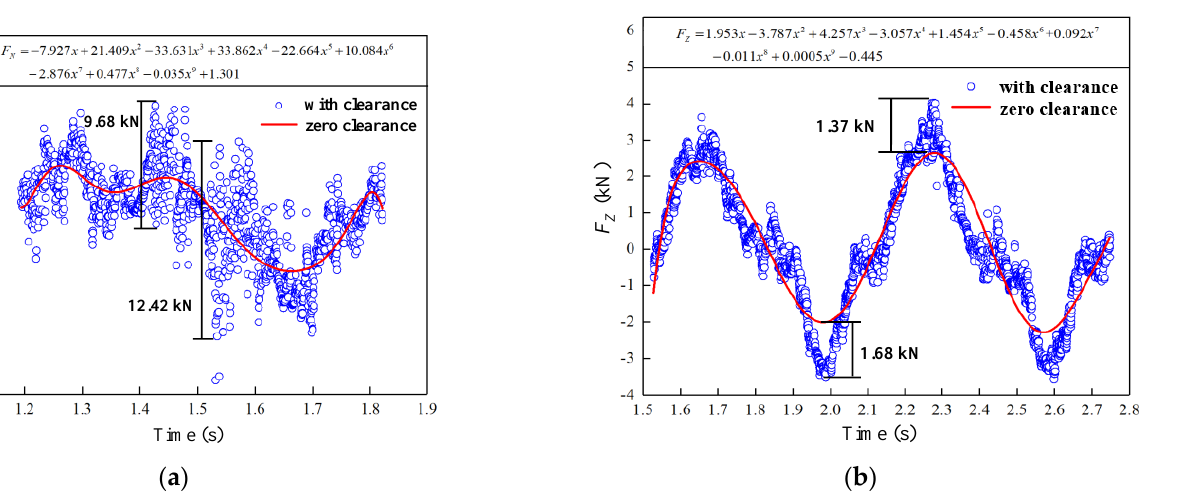
Figure 13. The influence of clearance on contact force between cage and ball seat. ( a ) The normal contact force (1.18 s – 1.82 s); ( b ) The axial contact force (1.52 s – 2.75 s).